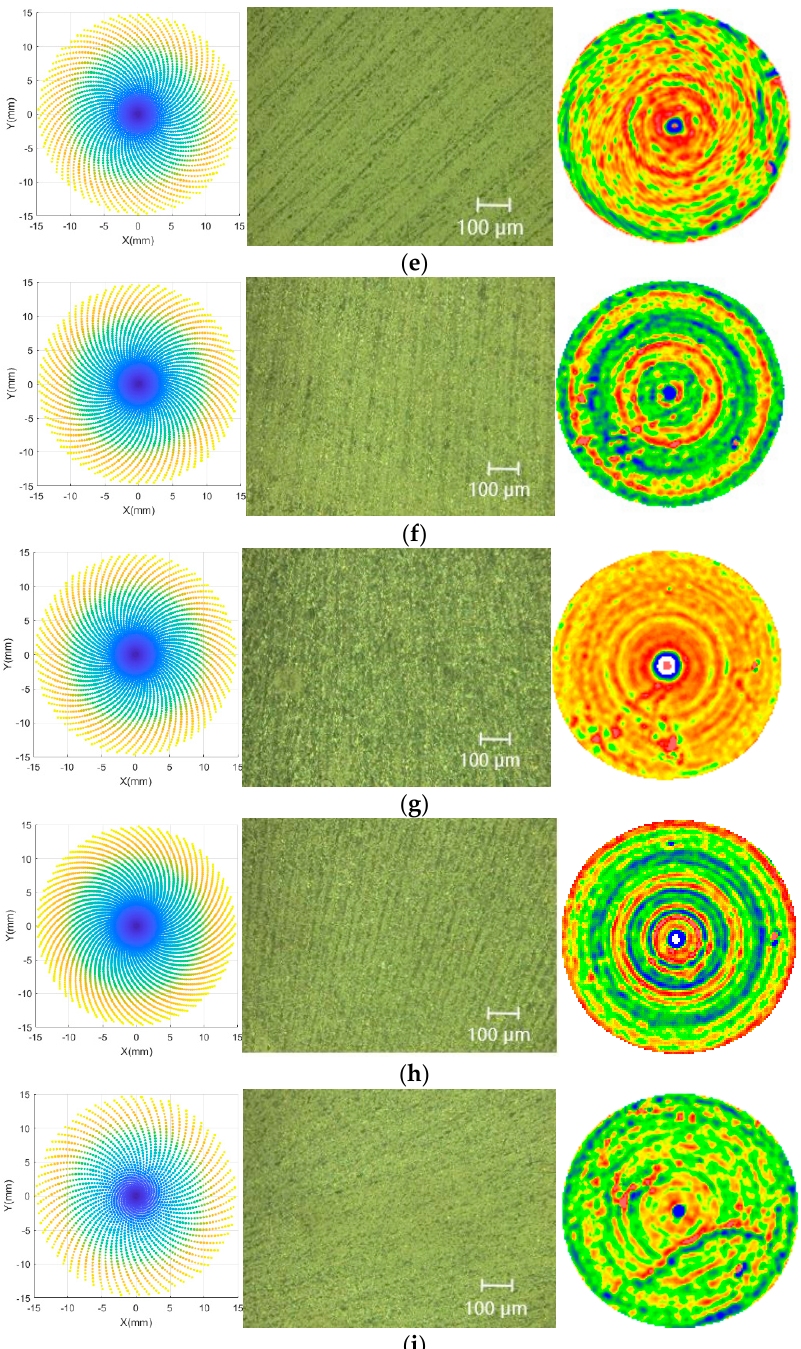
Figure 2. Matching results of different parameters. ( a ) Grinding wheel speed of 2635 rpm, workpiece speed of 30 rpm, and feed speed of 3 mm/min. ( b ) Grinding wheel speed of 2635 rpm, workpiece speed of 40 rpm, and feed speed of 3 mm/min. ( c ) Grinding wheel speed of 2635 rpm, workpiece speed of 50 rpm, and feed speed of 3 mm/min. ( d ) Grinding wheel speed of 2635 rpm, workpiece speed of 60 rpm, and feed speed of 3 mm/min. ( e ) Grinding wheel speed of 2635 rpm, workpiece speed of 70 rpm, and feed speed of 3 mm/min. ( f ) Grinding wheel speed of 2721 rpm, workpiece speed of 50 rpm, and feed speed of 3 mm/min. ( g ) Grinding wheel speed of 2871 rpm, workpiece speed of 50 rpm, and feed speed of 3 mm/min. ( h ) Grinding wheel speed of 2635 rpm, workpiece speed of 50 rpm, and feed speed of 2 mm/min. ( i ) Grinding wheel speed of 2635 rpm, workpiece speed of 50 rpm, and feed speed of 4 mm/min.